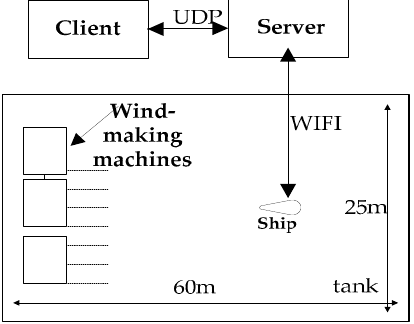
Figure 6. Tank experiment model.